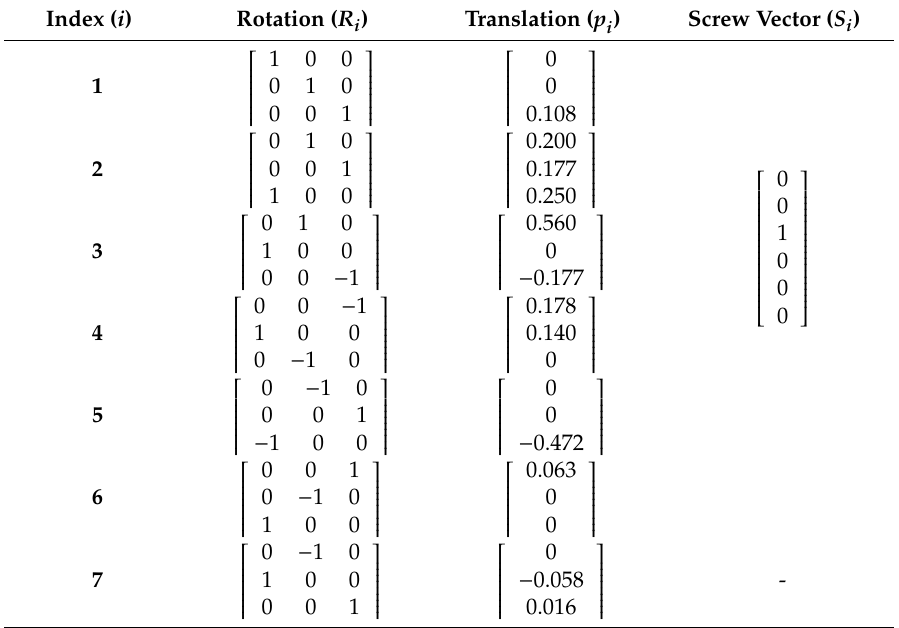
Table 1. Coordinate transformation matrices and screw vectors for the 6-DoF